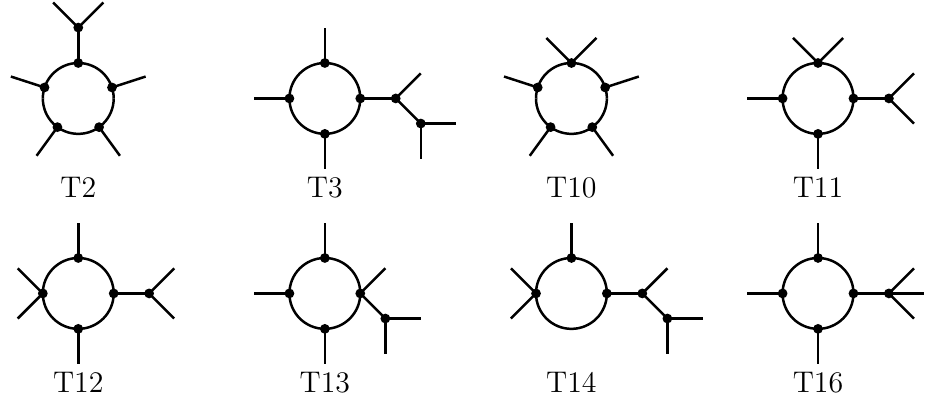
Figure 13 . Topologies that can lead to a genuine d = 7 1-loop neutrino mass model. T11 is the only topology for which the largest representation can be as small as a SU(2) L triplet. For all other topologies at least one quadruplet must appear in the diagram for the model to be genuine. The quadruplet diagrams based on those topologies are shown in (cid:12)gures 18, 19 and 20. For the triplet model see (cid:12)gure